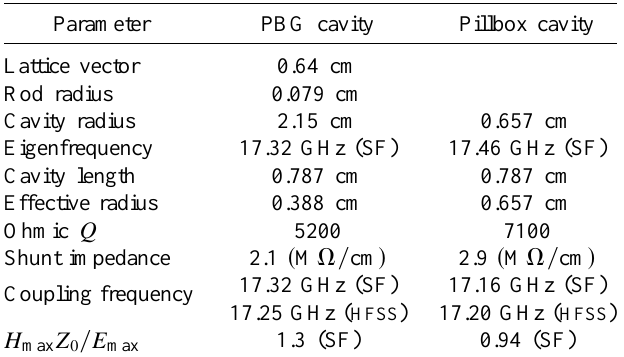
TABLE I. PBG cavity and equivalent pillbox cavity parameters. (SF: SUPERFISH ).